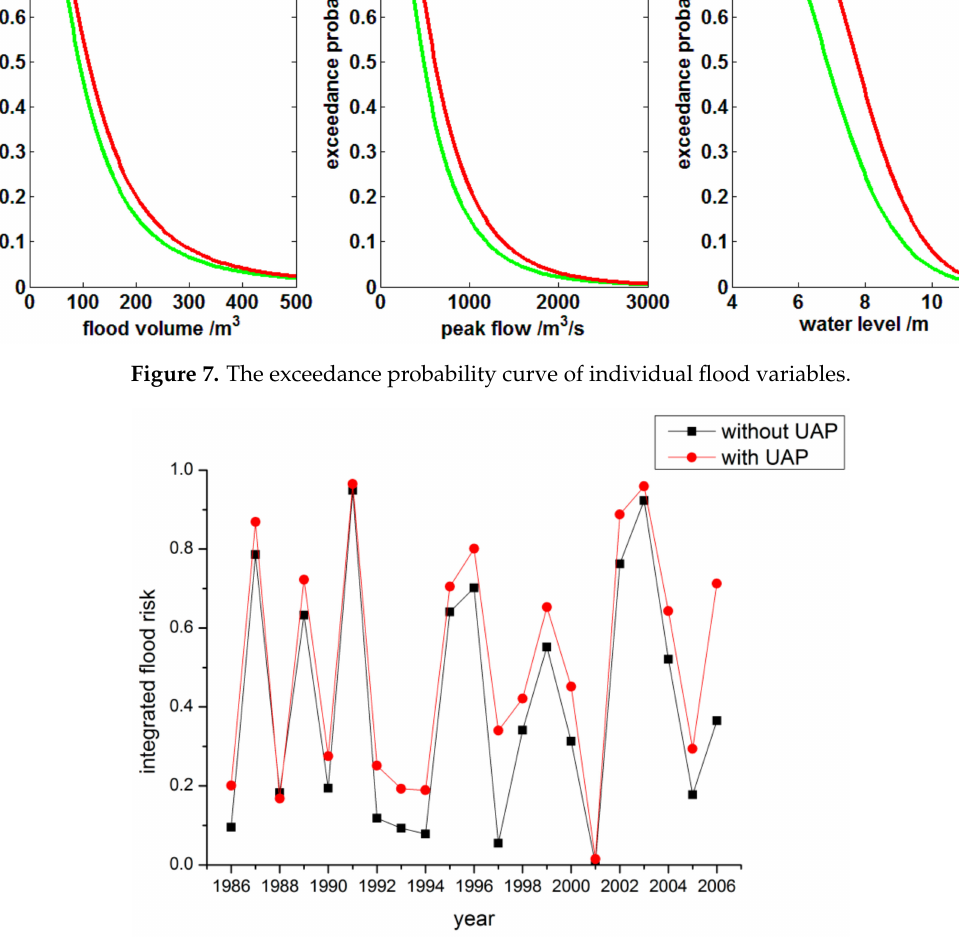
Figure 8. Integrated flood risk comparison of Qinhuai River Basin with and without